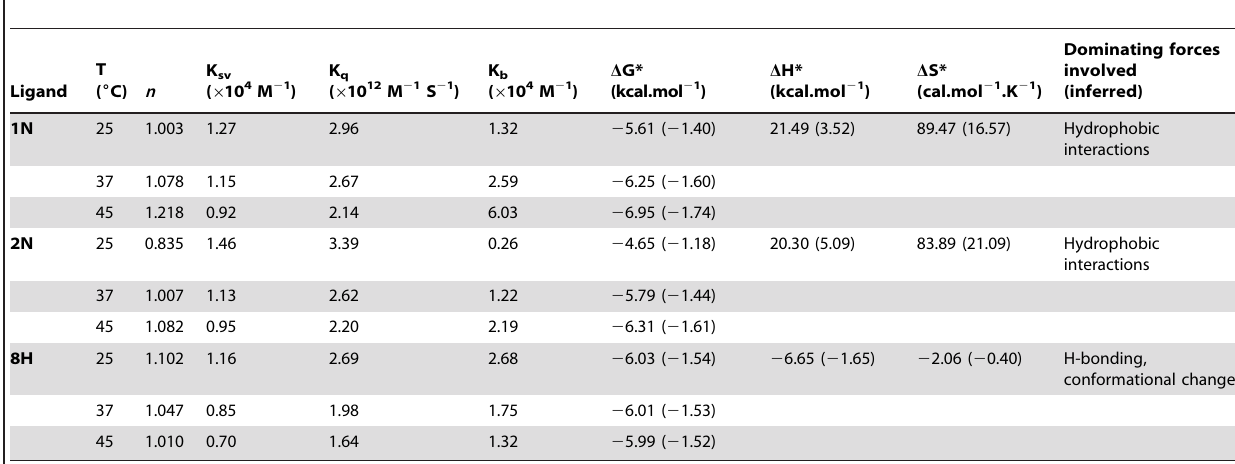
Table 3. Binding parameters of pollutant interaction to HSA in 20 mM Tris buffer pH 7.4 at different temperature obtained and calculated from fluorescence quenching results.